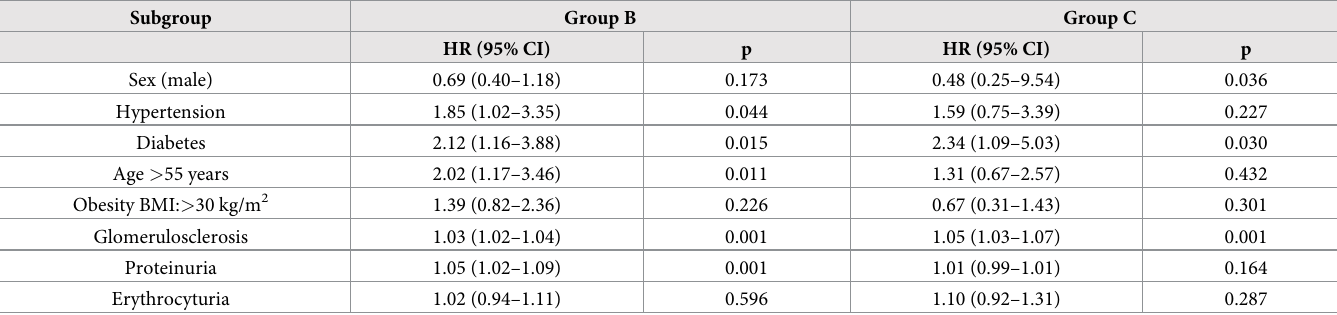
Table 4. Subgroup analysis of subnephrotic range